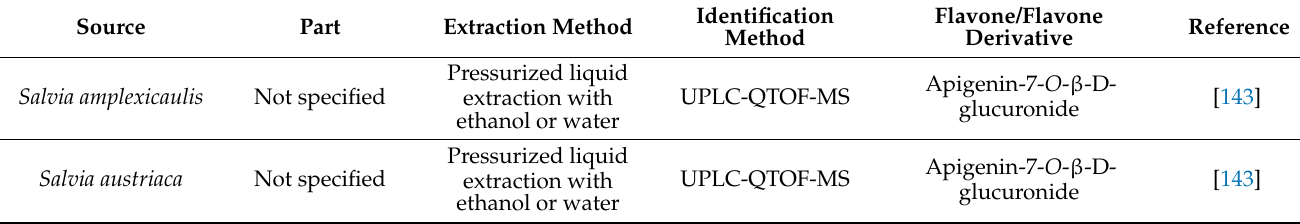
Table 4. Alternative extraction methods of flavones from Salvia , Ocimum , Origanum , and Thymus species.